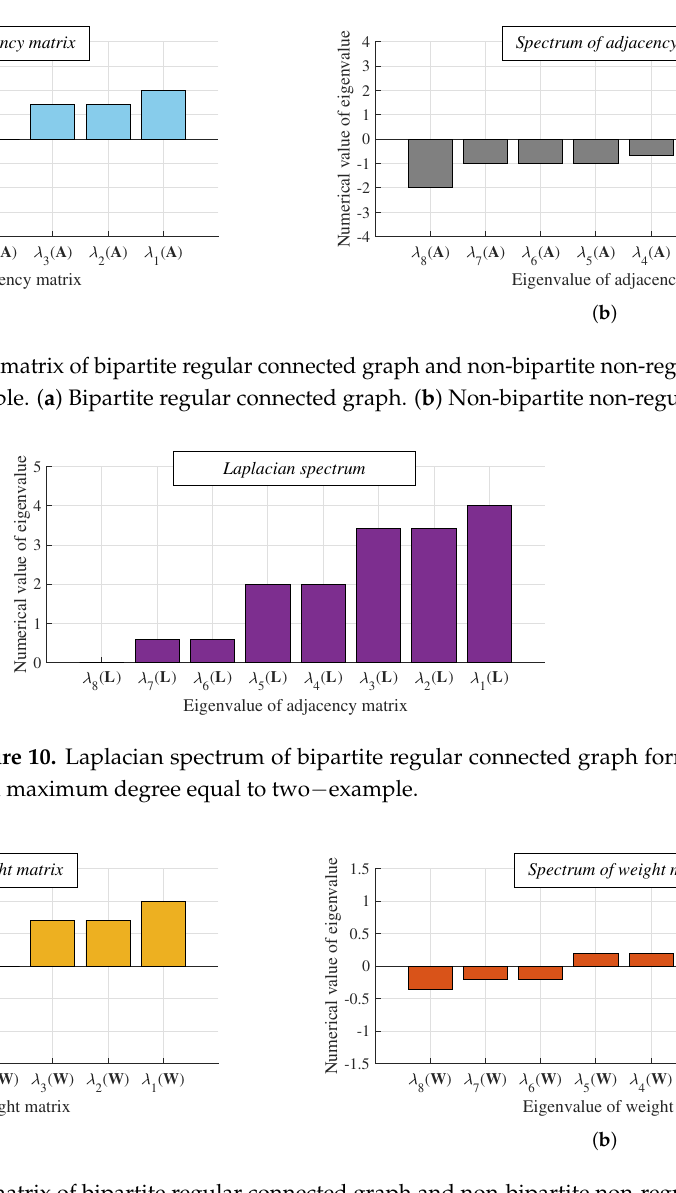
Figure 11. Spectrum of weight matrix of bipartite regular connected graph and non-bipartite non-regular graph formed by eight vertices and with mixing parameter equal to 1/ ∆ − example. ( a ) Bipartite regular connected graph. ( b ) Non-bipartite non-regular connected